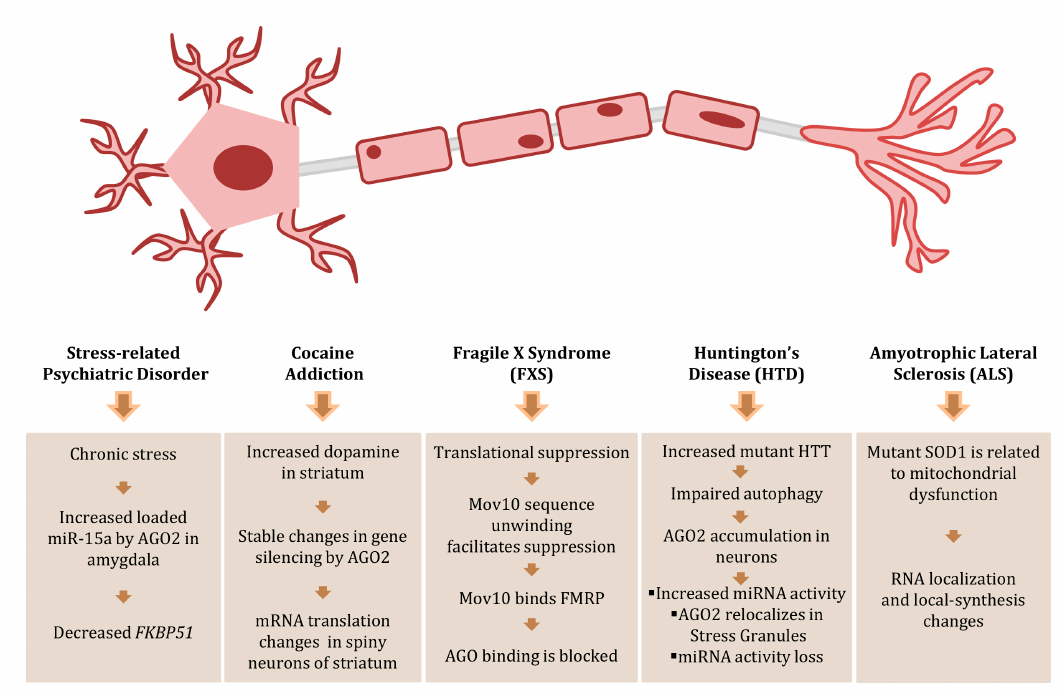
Figure 4. Argonaute (AGO) engagement in human neuropathology. Graphical overview of the AGO-associated pathologies in neurodegenerative diseases, such as ALS, HD, and in neuro-dependent diseases such as cocaine addiction and stress-related psychiatric